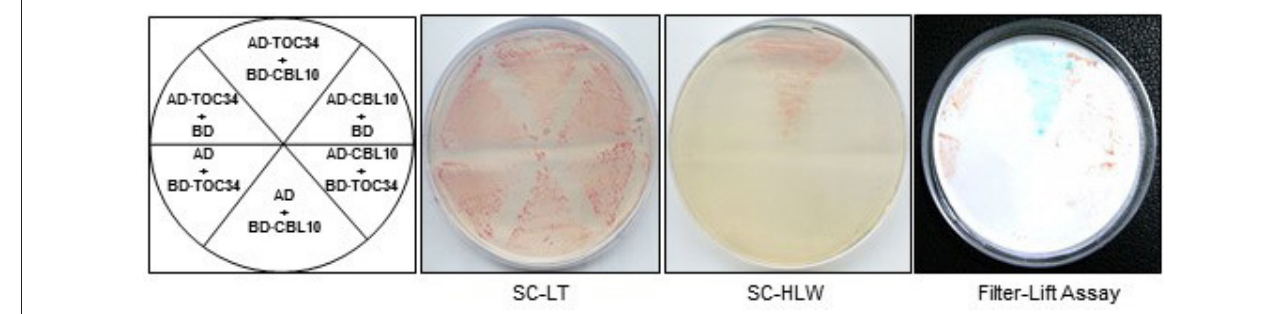
FIGURE 1 | A yeast two-hybrid assay showing that TOC34 interacts with CBL10 in a vector-dependent manner. The first panel at left shows the arrangement of the Y109 yeast cells harboring the indicated BD and AD plasmids. The second and third panels display yeast growth on synthetic complete medium lacking Leu and Trp (SC-LW) and synthetic complete medium lacking His, Leu, and Trp (SC-HLW), respectively. The last panel shows β -galactosidase activity using filter-lift